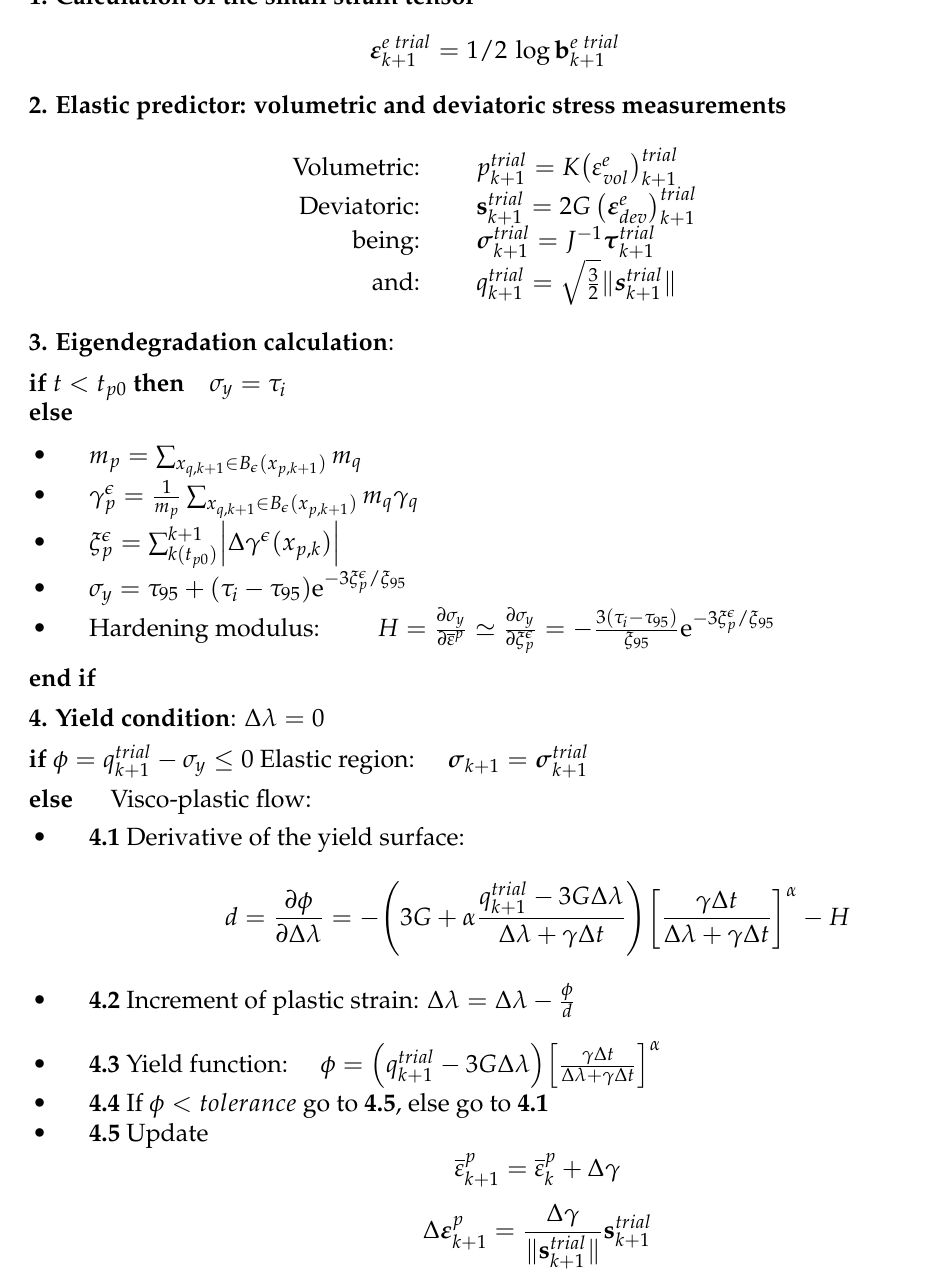
Algorithm 1 Visco-Plastic Eigendegradation